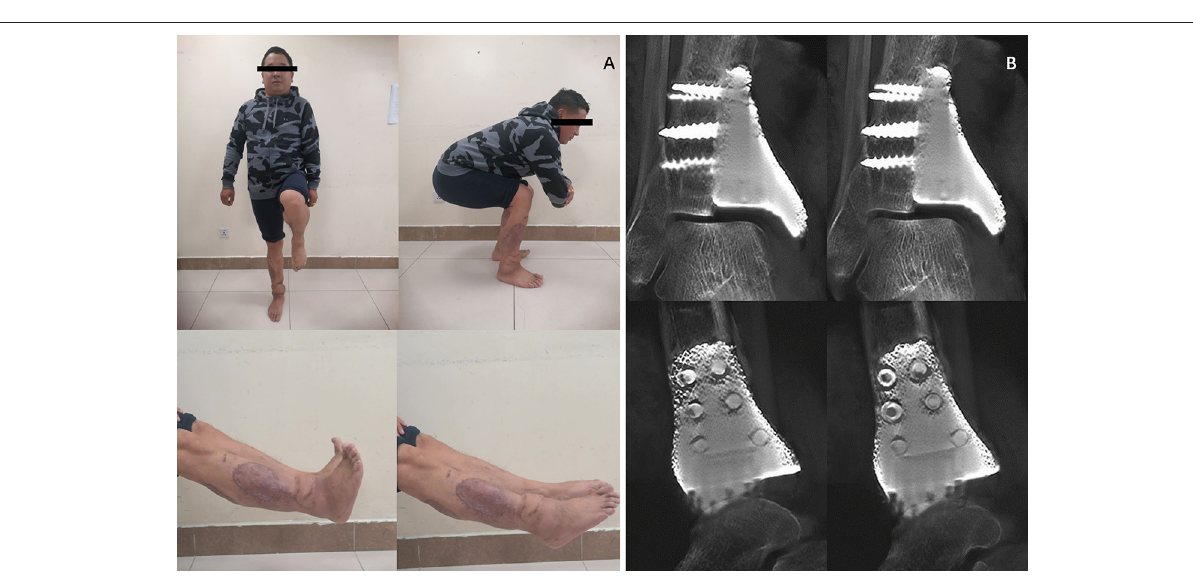
Patients who undergo joint reconstruction generally have better function. Niimi et al.